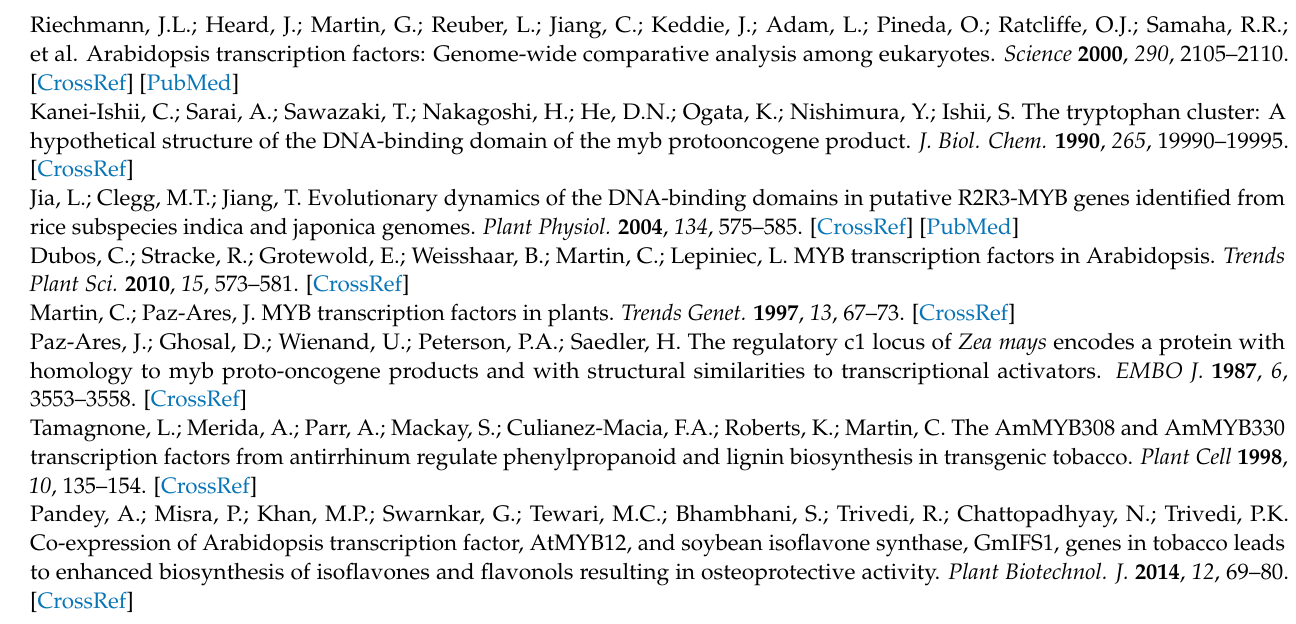
stress treatments; Table S1: Physicochemical Properties of the 2R-MYB Type Proteins; Table S2: Statistical Analysis of the Intron Numbers of 99 Os2R_MYB Genes; Table S3: R2R3_MYB proteins interaction network construct; Table S4: R2R3_MYB proteins interaction network protein annotations; Table S5: R2R3_MYB proteins interaction network functional annotations; Table S6: Statistical Analy- sis of Os2R_MYB Genes Expression Level under the PEG and CdCl2 Stresses; Table S7: Quantitative RT-PCR